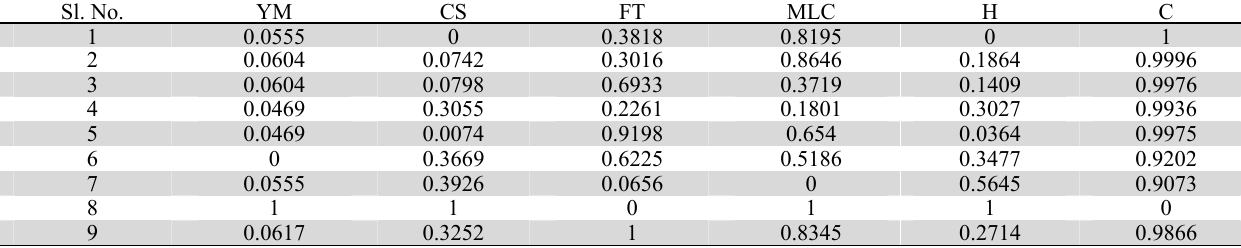
Normalized decision matrix for example 4 Sl.